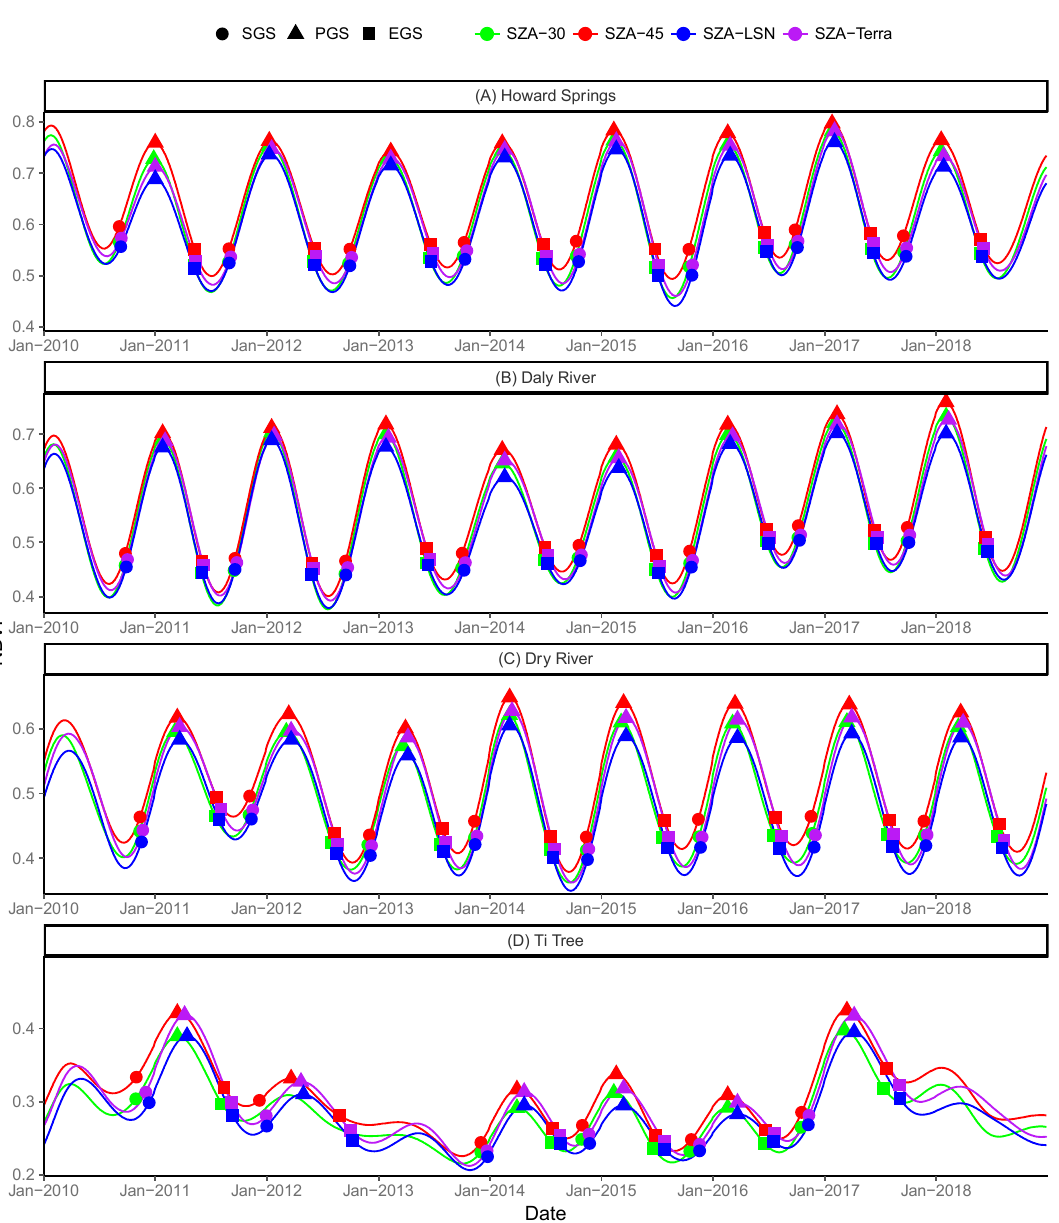
Figure 8. Time series of MODIS NDVI at four NATT sites from 2010 to 2018. The light colour lines are original time series and the dark colour lines are gap-filled and reconstructed time series. Phenological transition dates are indicated on each line, including the start of greening season (SGS, solid circle), the peak of greening season (PGS, solid triangle), and the end of greening season (EGS, solid rectangle). Phenological metrics extracted from NDVI with three different SZA configurations (all at nadir view), with SZA varying according to the Terra overpass time (SZA-Terra) and the local solar noon (SZA-LSN), or fixed at 30° (SZA-30) or 45° (SZA-45).